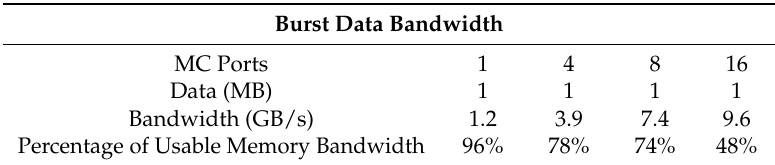
Table 2. Burst data bandwidth (different number of MC ports—dataset 1